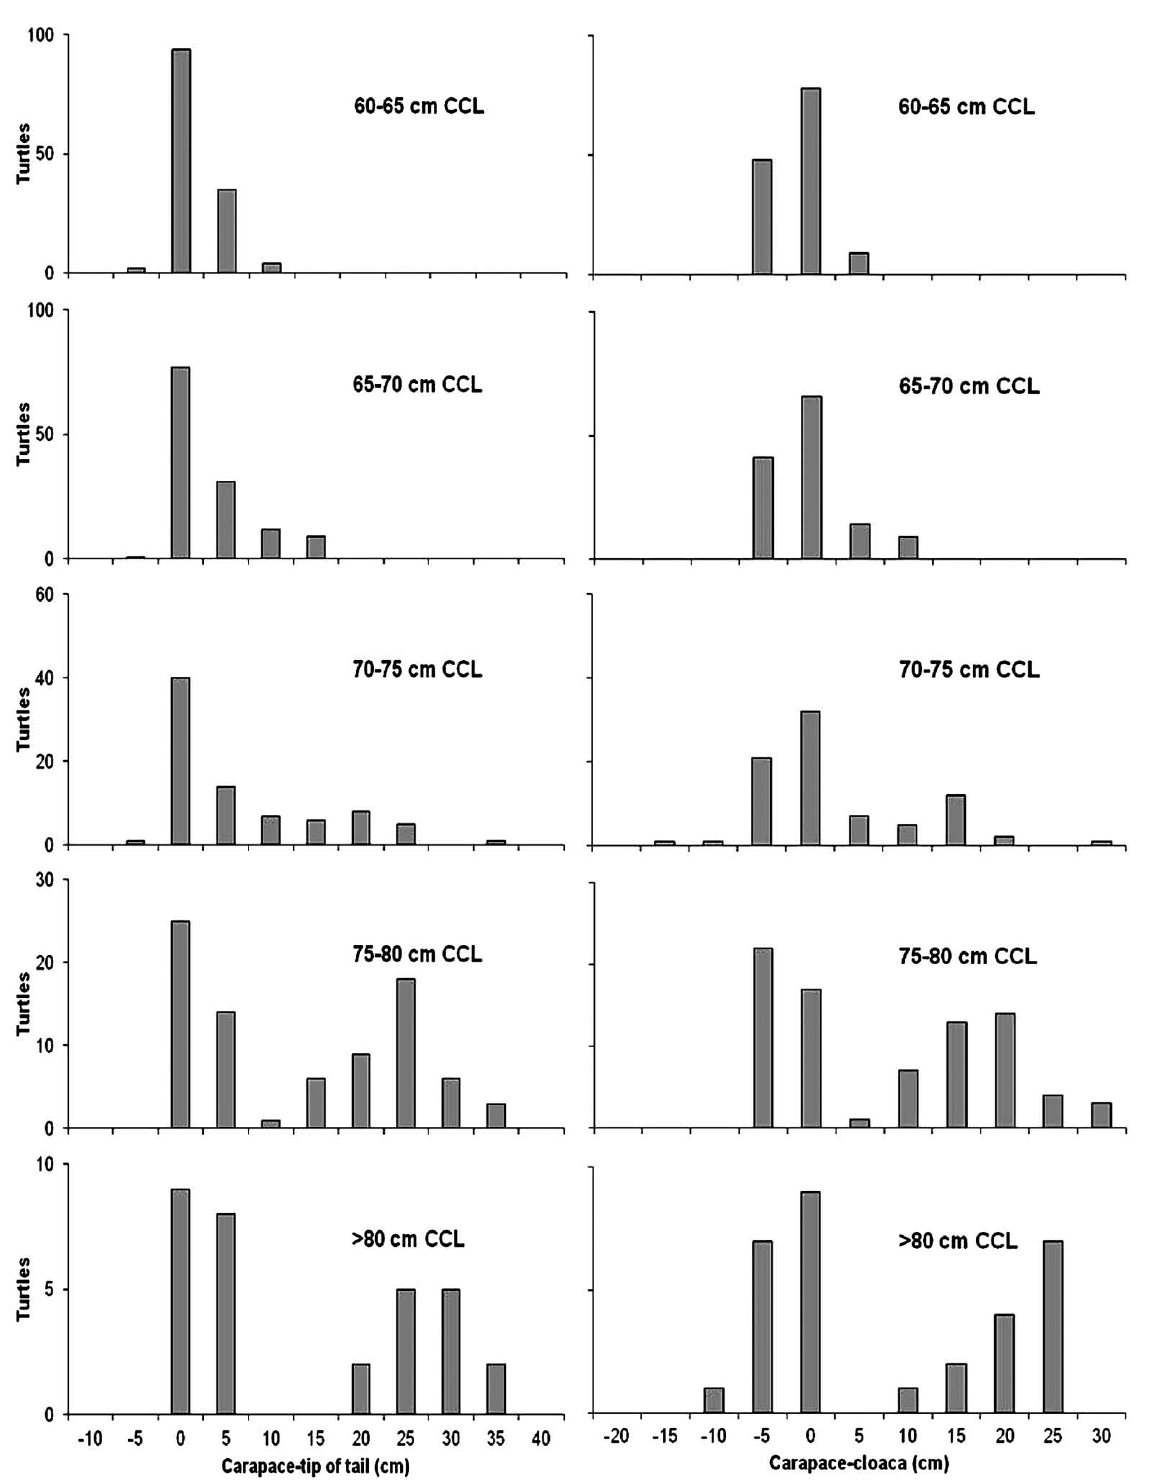
Fig. 3. – Frequency distribution of two measures of the tail (carapace-tail and carapace-cloaca) in different 5-cm size classes (curved carapace length, CCL) of 460 loggerhead sea turtles from the Tunisian shelf, central